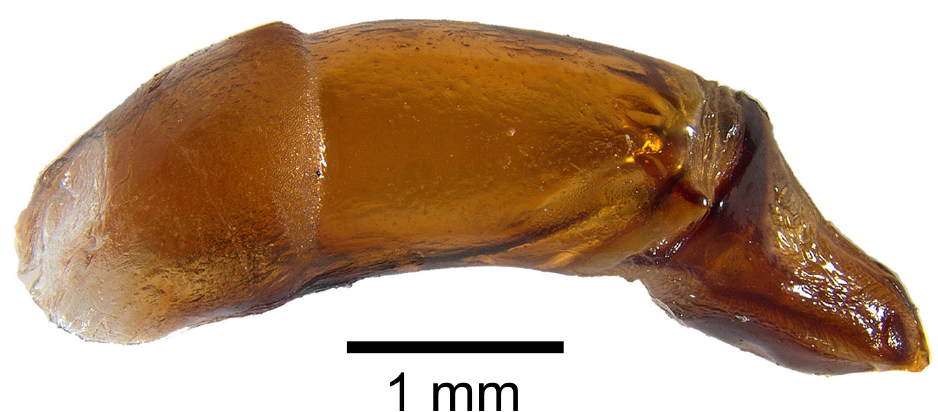
Fig. 20. Lateral view of the aedeagus of the Phanaeus endymion species group ( P. endymion Harold,